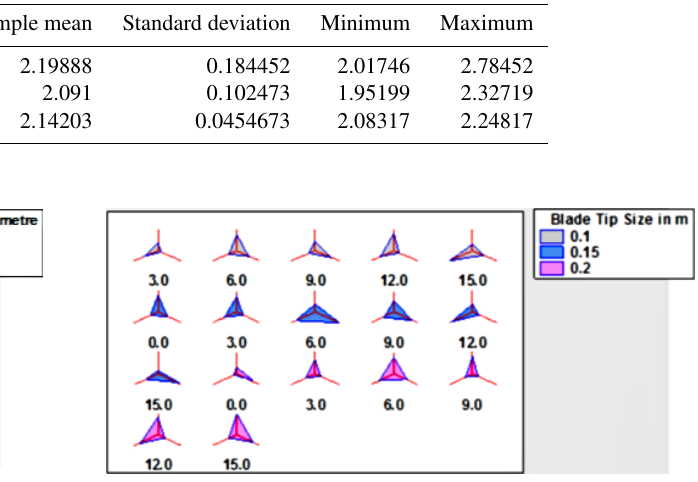
Figure 12. Sunray plot illustrating torque for blade tip sizes of 0.1, 0.15, and 0.2m and blade twist angles of 0, 3, 6, 9, 12, and 15 ◦ for three NACA airfoils.